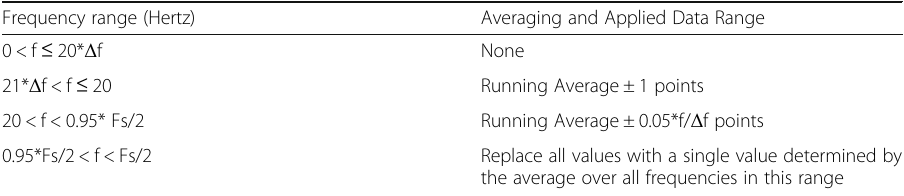
Table 1 Spectral local data averaging procedures over different frequency ranges Frequency range (Hertz) Averaging and Applied Data